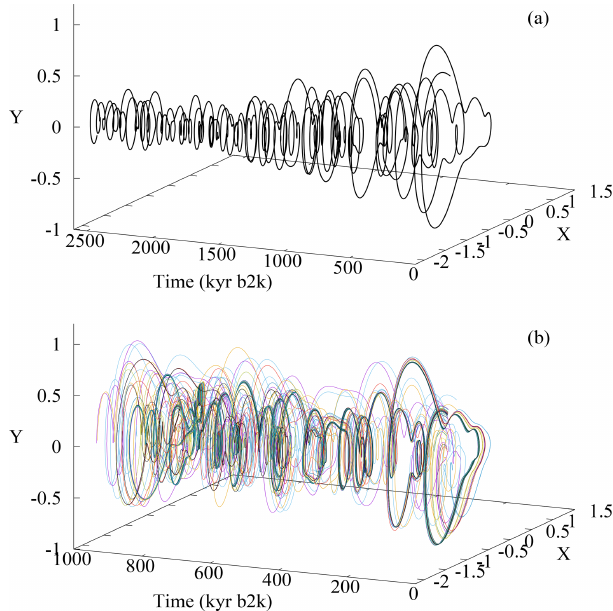
Figure 14. PBA of the M-DD16 model governed by Eq. (28), ap- proximated by 40 trajectories starting from random initial condi- tions in ( x,y ) ∈ [− 2 , 2 ]×[− 2 , 2 ] at t = − 10000kyr. (a) The PBA corresponding to Fig. 13, with the slowly changing parameters α ( t ) and β ( t ) given by Eq. (30). (b) The PBA for α ( t ) and β ( t ) kept con- stant at the post-MPT values of α = 0 . 7 and β = 3 . 9. In panel (b) , the PBA is shown over a shorter time interval of the last 1000kyr so that the detailed structure is more clearly visible. Without changes in α and β in time, the overall structure of the PBA is similar before and after